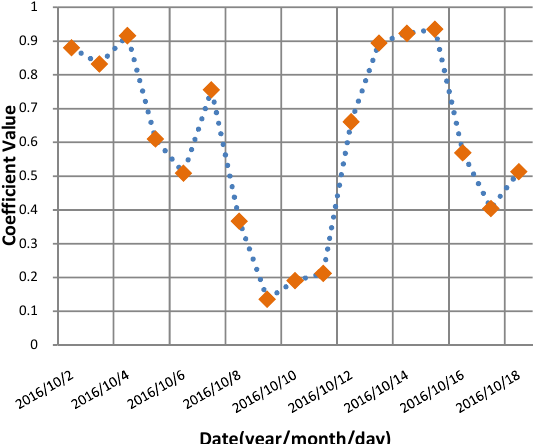
Figure 5. Pearson correlation coefficient value between roads and